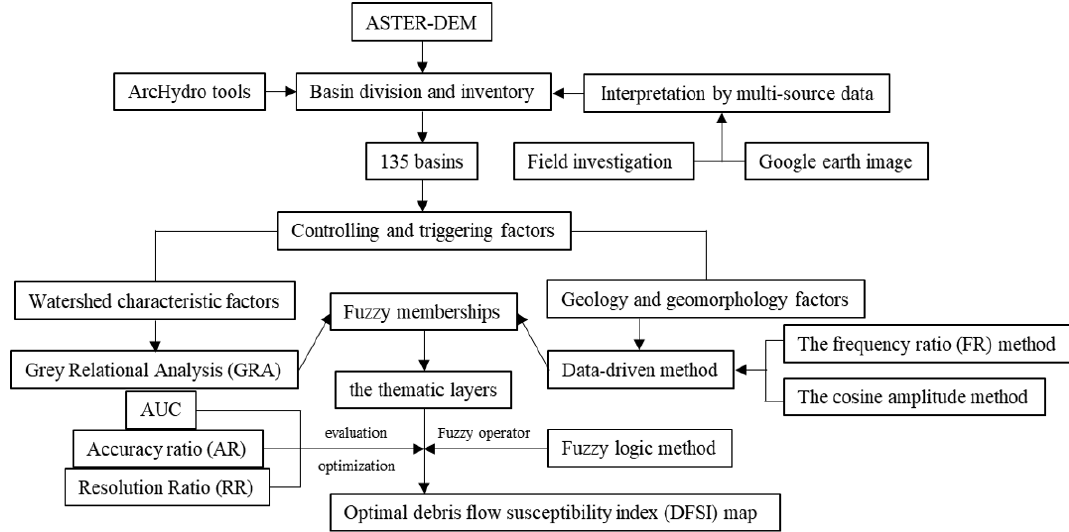
Figure 2. Workflow of debris flow susceptibility assessment.